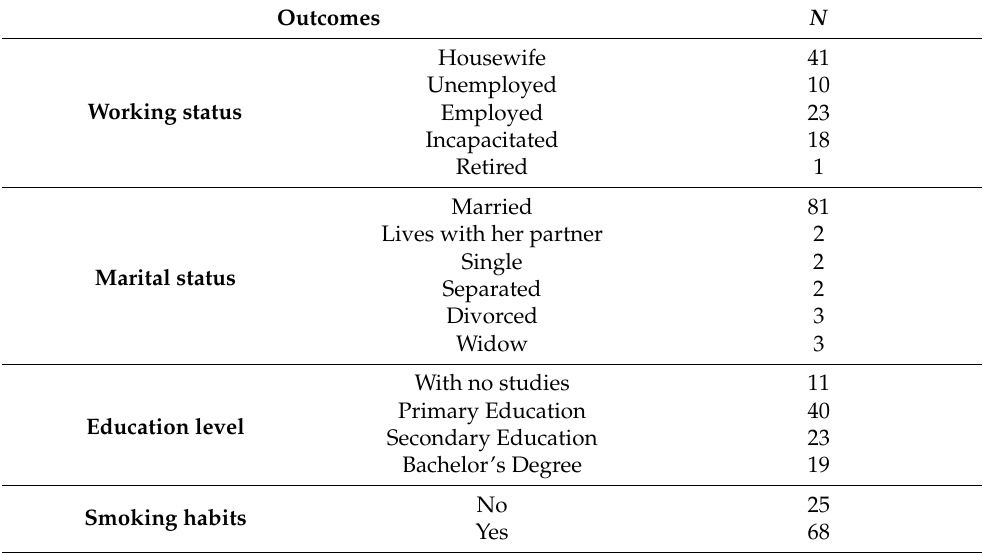
Table 1. Socio-demographic characteristics of the